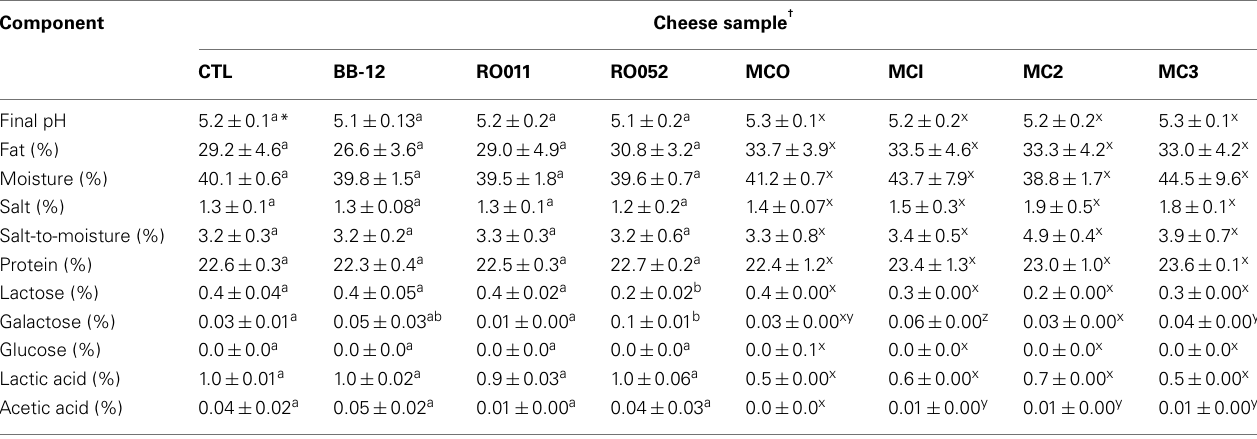
Table 7 | Chemical composition of each cheese sample after 14days of ripening at